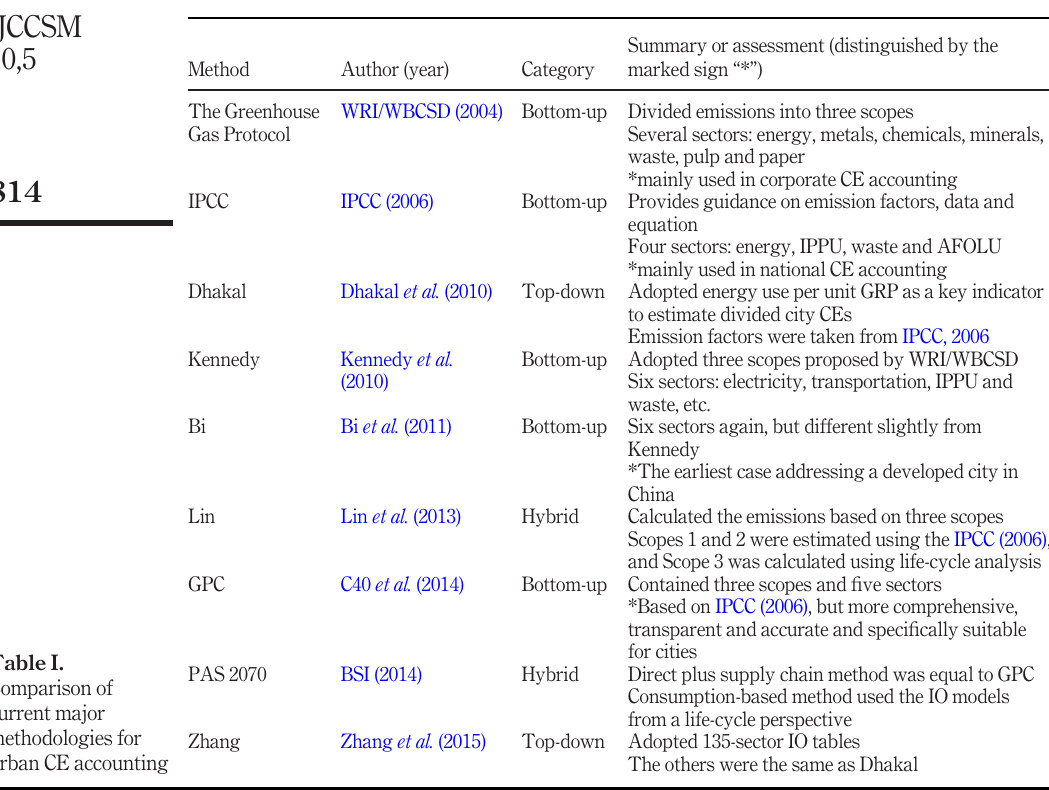
Table I. Comparison of current